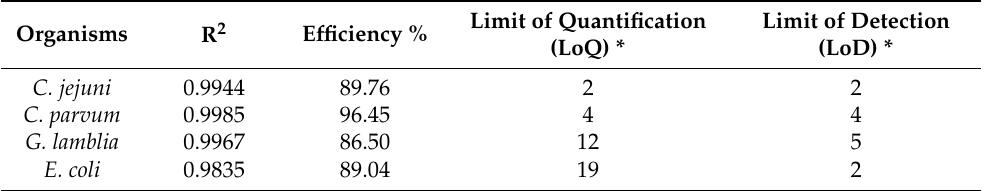
Table 2. Sensitivity and efficiency of the qPCR against individual pathogens. Efficiency %—amplification efficiency. Limit of quantification (LoQ) and limit of detection (LoD) determined via serial dilution (Supplementary Table S4). * Expressed as cells or genome copies/PCR